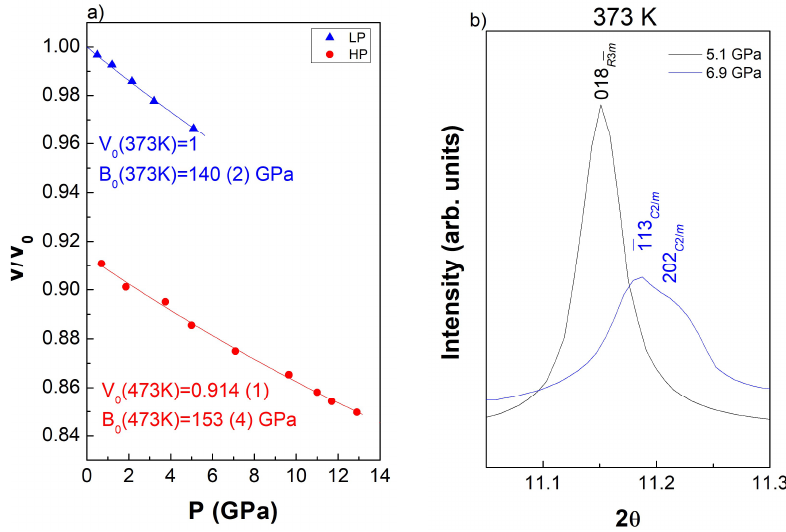
Figure 2. ( a ) Pressure dependence of the LuFe 2 O 4 rhombohedral low pressure (at 373 K) and monoclinic M2 high pressure forms (at 473 K); ( b ) evidence of the apparition of a monoclinic distortion with increasing pressure. The obtained monoclinic reflections are indexed in the ambient temperature monoclinic C 2/ m space group.